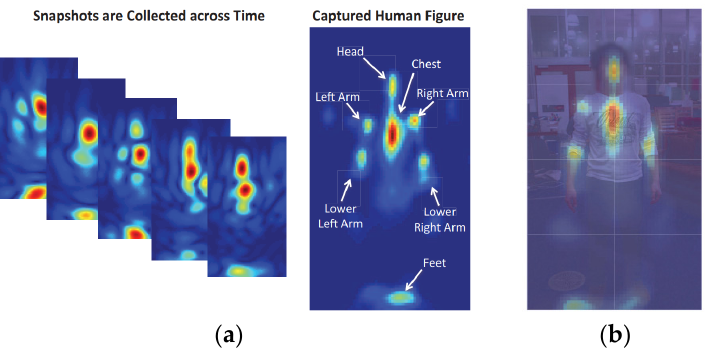
Figure 2. Human Contour was generated by FMCW [44]. Figure ( a ) shows contours of the human body that were generated from snapshots that were collected at various times, and ( b ) compares contours that were generated by RF and the poses of real human bodies.